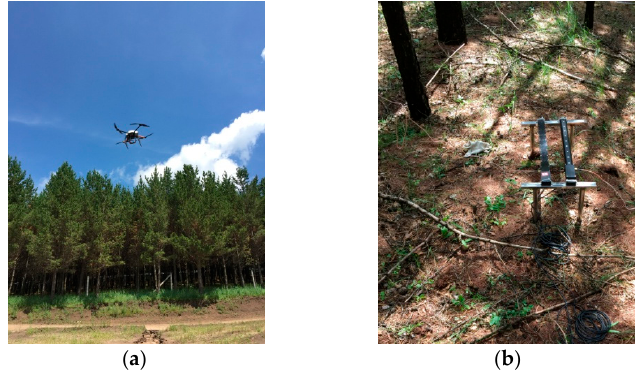
Figure 4. Field measurements at Saihanba: ( a ) The remote control aircraft with a photon flux sensor measuring the photosynthetically active radiation (PAR) over the canopy; ( b ) A pair of photon flux sensors fixed on the ground measuring the PAR under the canopy.